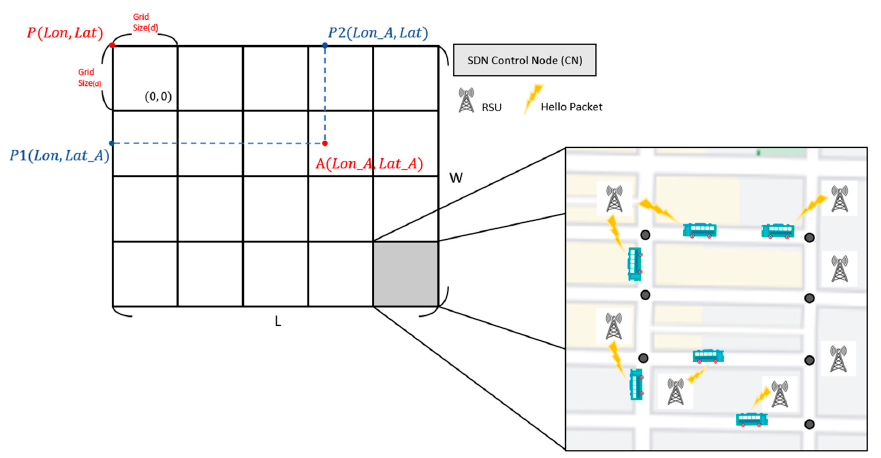
Figure 4. SD-QGrid network architecture.